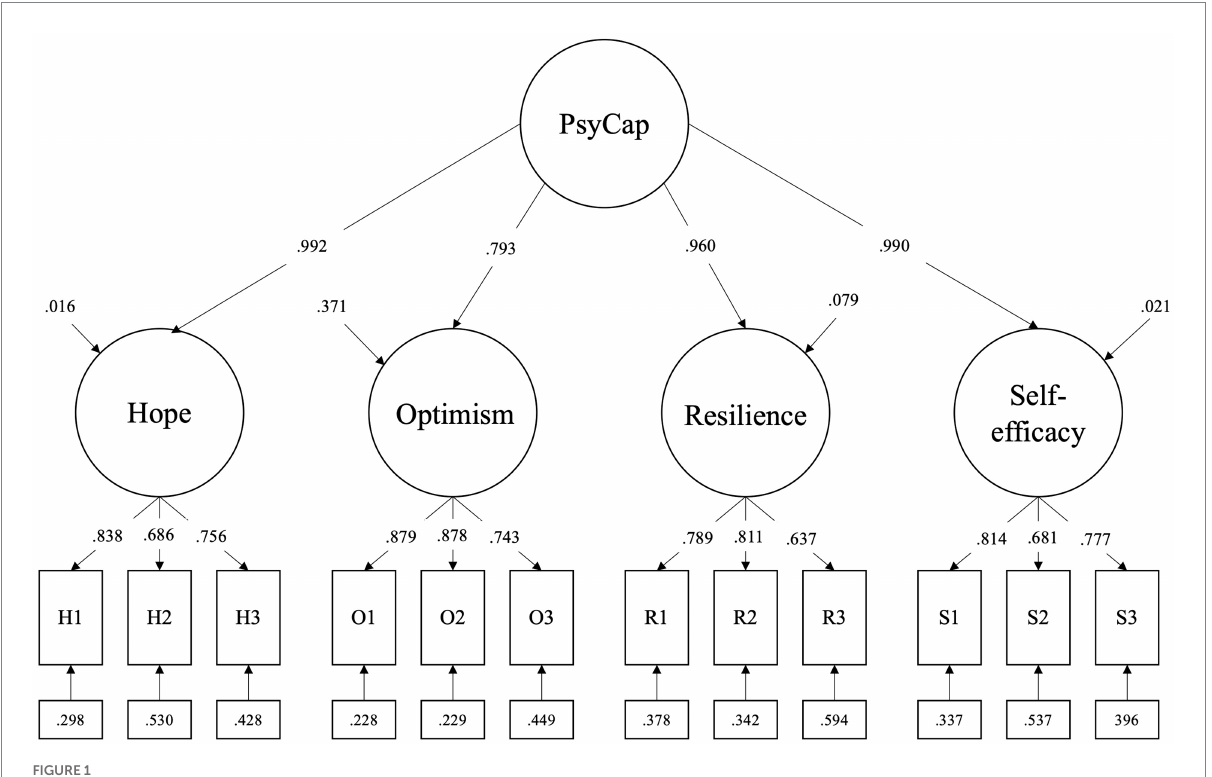
FIGURE 1 Results of confirmatory factor analysis in the model of the previous